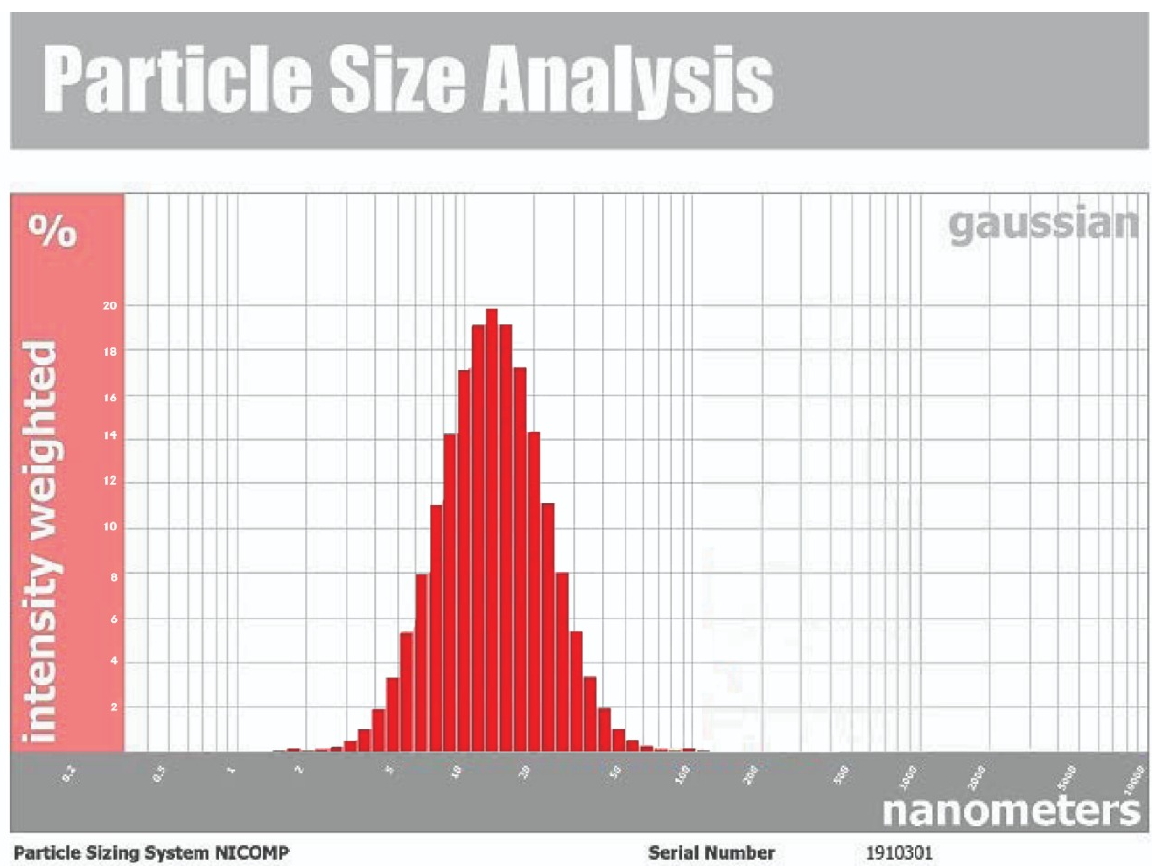
Figure 3. The DLS spectrum for silver nanoparticles. The average particle size was 15.3 nm.